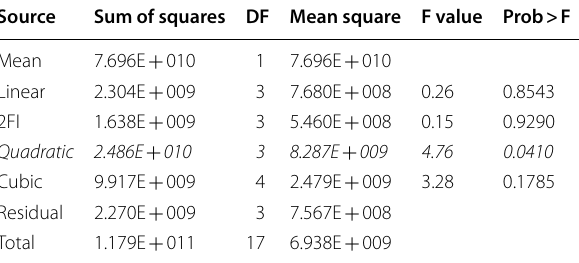
Table 2 Investigation of the independent and interaction effect of variables on each response Source